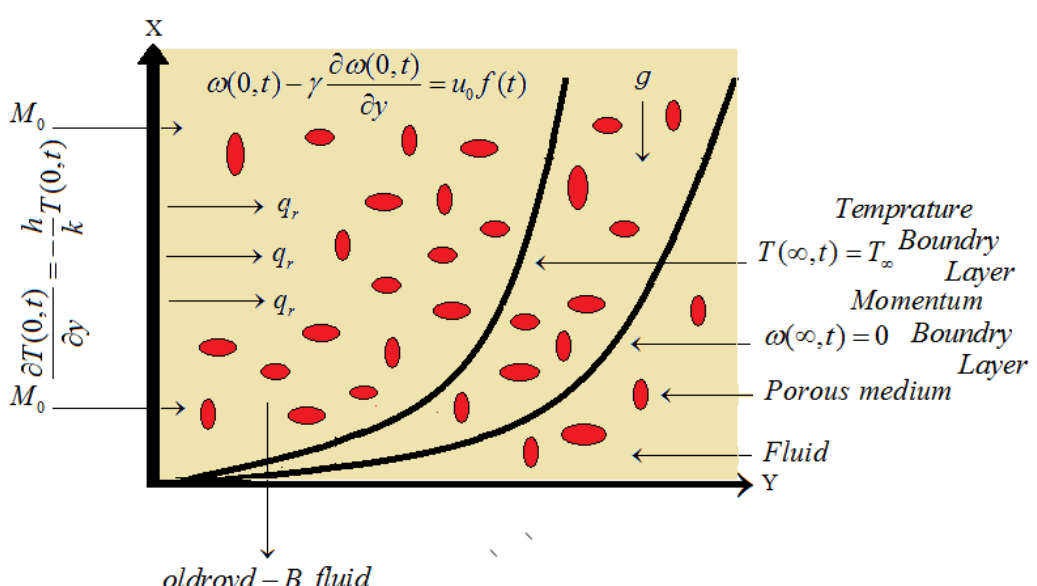
Figure 1. Geometry of the considered